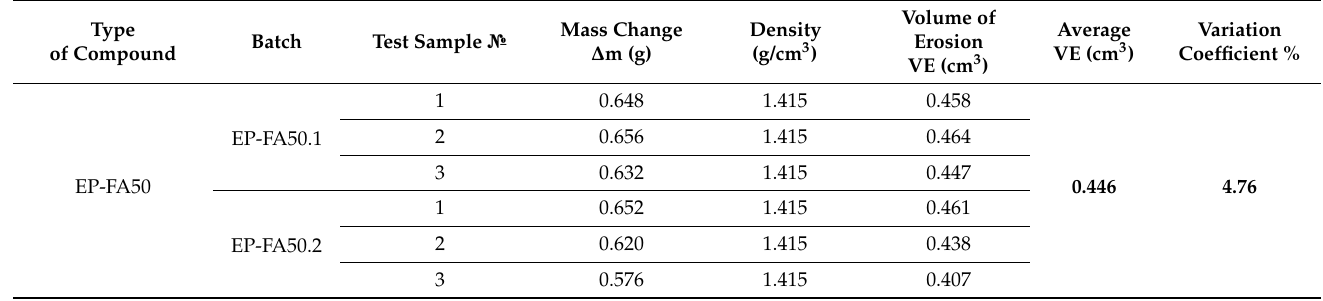
Table A15. Wear of filled epoxy binder (EP-FA50) at 100 ◦ C at an impingement angle of 90 ◦